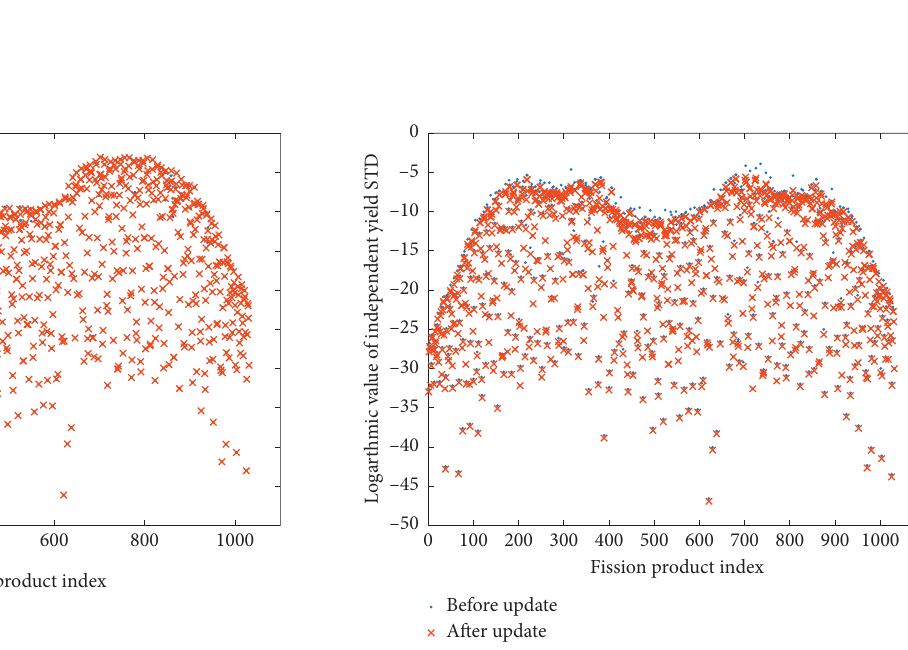
Figure 5: Estimated IFYs correlation matrix. (a) All the estimated correlation information. (b) Section of the estimated correlation information. Red dot indicates the positive correlation and blue dot indicates the negative correlation. The fission product index refers to each fission product identified by its charge number Z , mass number A , and isomeric state I ( ZZAAAI ) . These indices are grouped by the mass number and arranged in a descending manner. For each mass group, charge number is ordered in an ascending manner to cooperate the β − decay.